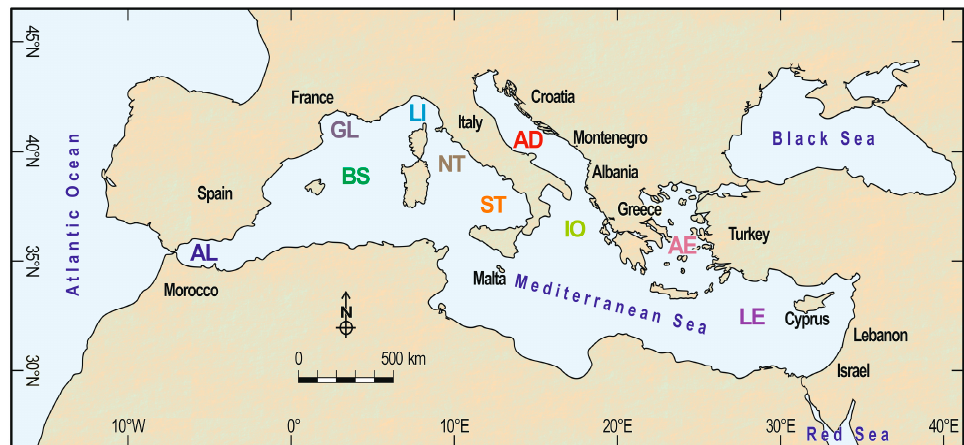
Figure 1. Map of the Mediterranean Sea with countries and marine sectors where cave decapods have been reported. AL = Alboran Sea; BS = Balearic and Sardinia seas; GL = Gulf of Lion; LI = Ligurian Sea; NT = North Tyrrhenian Sea; ST = South Tyrrhenian Sea; AD = Adriatic Sea; IO = Ionian Sea; AE = Aegean Sea; LE = Levantine Sea.